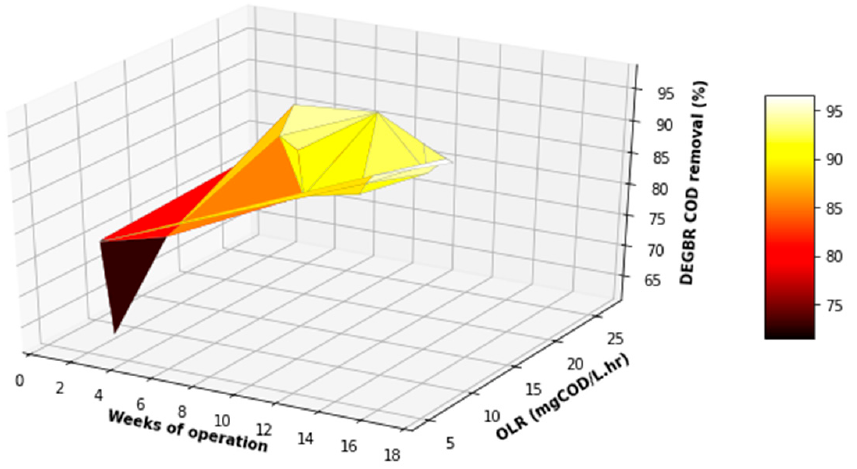
Figure 12. Performance of the DEGBR with respect to the COD removal under varying OLRs.